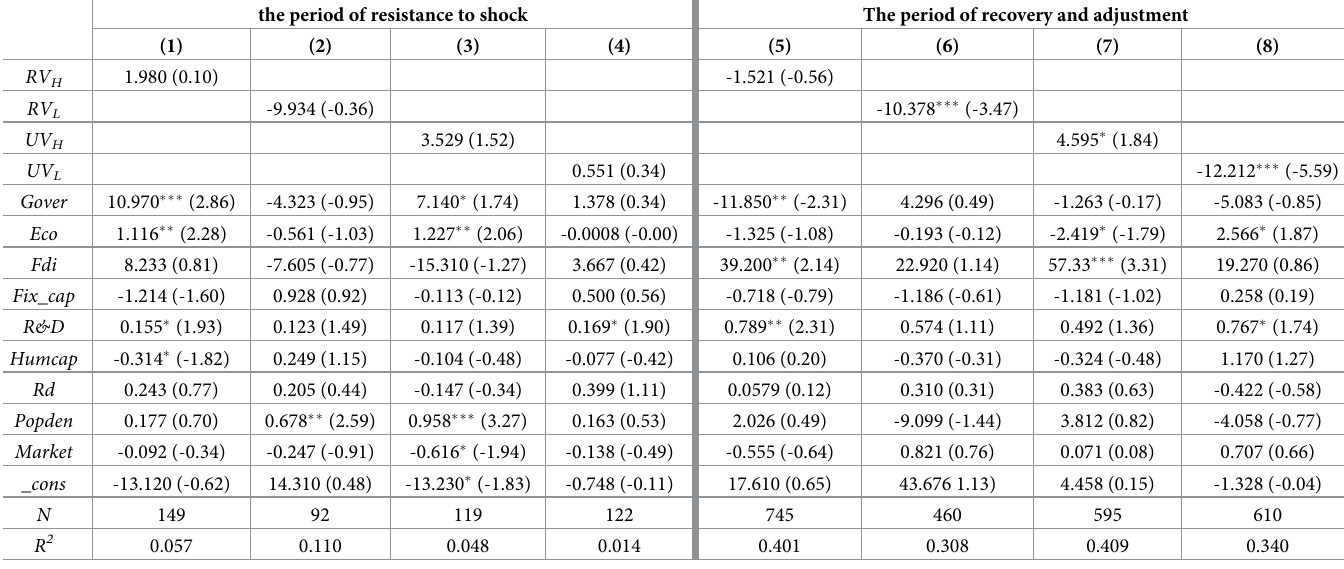
Table 5. The effects of related and unrelated diversified agglomerations with different levels on urban economic resilience. the period of resistance to